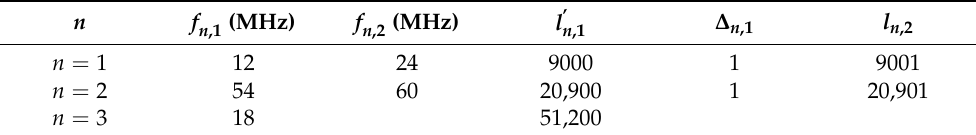
Table 1. The parameters of the multiple FH